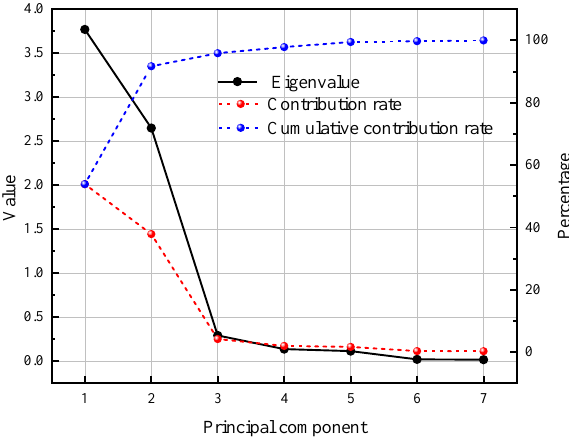
Figure 7. Eigenvalues and corresponding contribution rate. Table 8. The eigenvector value of each